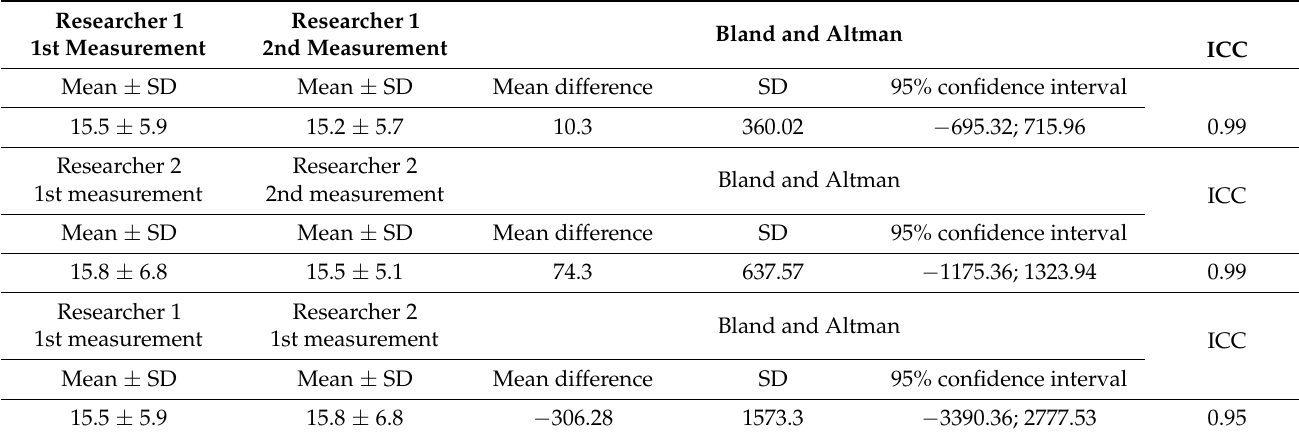
Table 4. Intra- (Researcher 1 and Researcher 2) and inter-examiner (Researcher 1 vs. Researcher 2) errors for total volume: mean, standard deviation (SD), Bland and Altman agreement and intraclass correlation coefficient (ICC).